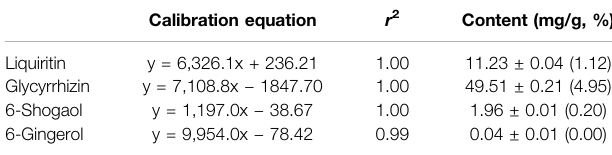
TABLE 1 | Calibration curves and content of standard compounds in LGD. Calibration equation